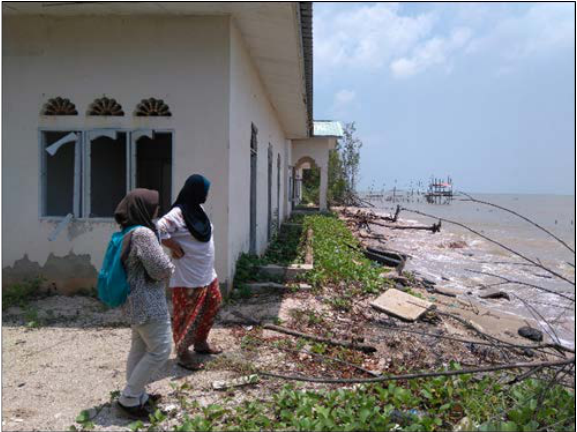
Figure 12. Erosion at Kampung Parit Hailam, Senggarang Figure 12 below show erosion that has damaged the infrastructure of coastal residents in Kampung Sungai